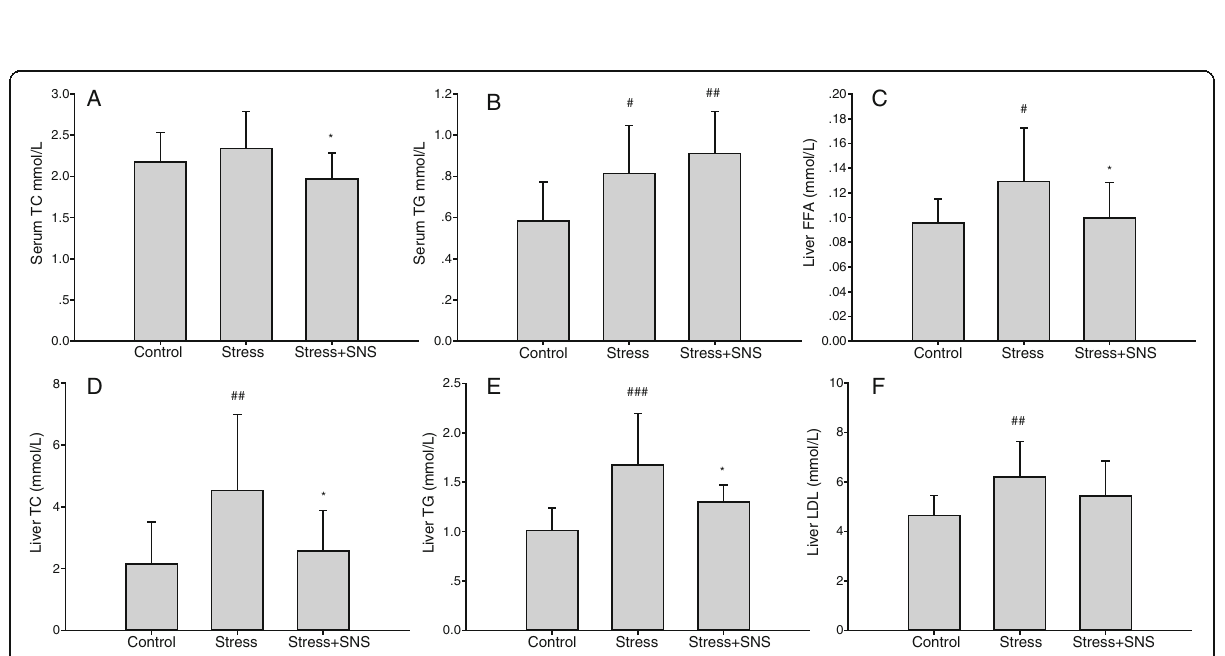
Fig. 3 Effects of chronic stress. Chronic stress induces the accumulation of hepatic triglyceride (TG), total cholesterol (TC), free fatty acids (FFA), and low-density lipoprotein (LDL), and Sinisan (SNS) treatment can decrease this accumulation. a The serum TC level is shown in the bar chart. b The serum TG level is shown in the bar chart. c The liver FFA level. d , e The liver TG and TC concentrations in each group. f The liver LDL level. Values plotted are a mean ± standard deviation ( N = 10 per group). # p < 0.05, ## p < 0.01, ### p < 0.001 versus the control group, * p < 0.05 versus the stress